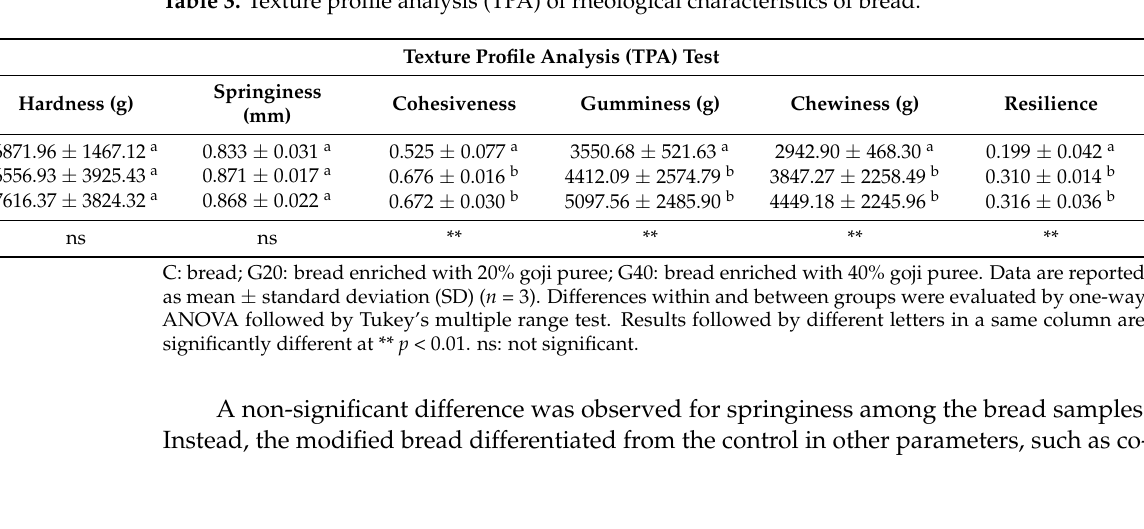
Table 3. Texture profile analysis (TPA) of rheological characteristics of